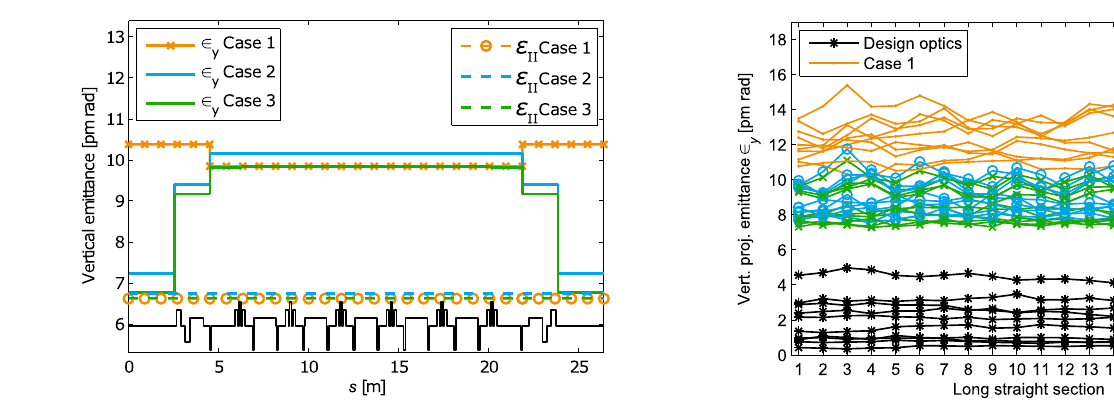
FIG. 10. Vertical projected emittance ϵ y in the long straight sections (ID locations) including lattice imperfections (10 error seeds) for the design optics and the three SCVDB cases.